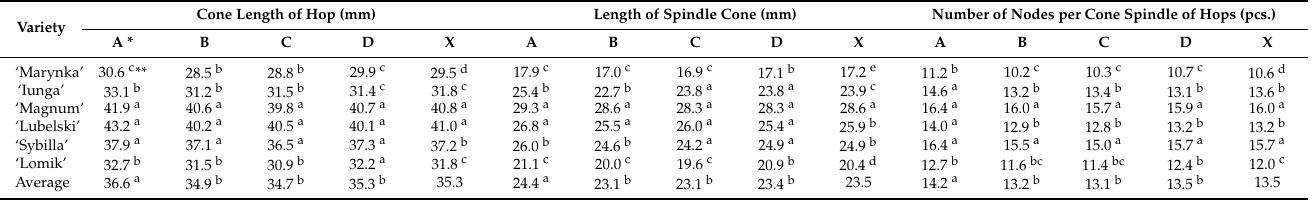
* Explanations as in Table 8. ** Letter indicators at the means (significant groups) define the so-called homogeneous (statistically homogeneous) groups. The presence of the same letter index with the means (at least one) means that there is no statistically significant difference between them. The subsequent letter indices a, b, etc., define the groups in ascending